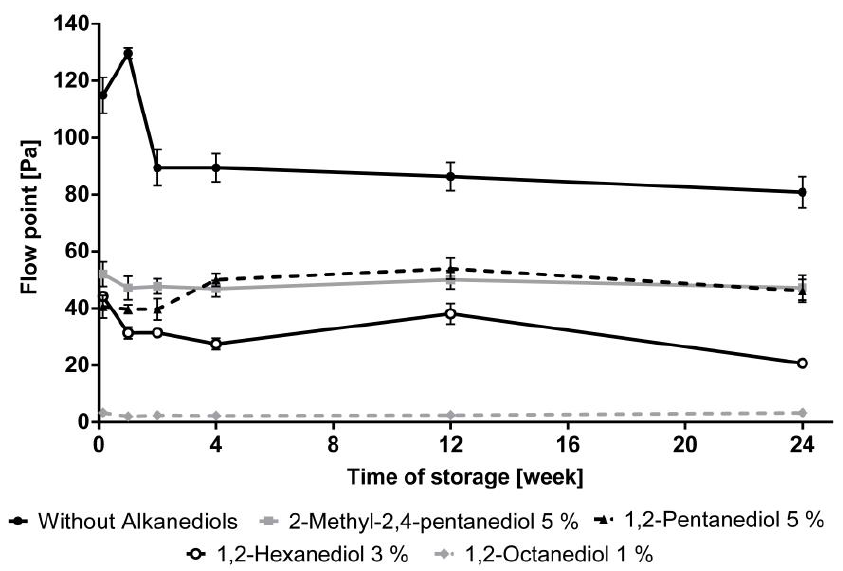
Figure 6. Influence of alkanediols on the flow point, n = 3, mean ± standard deviation.